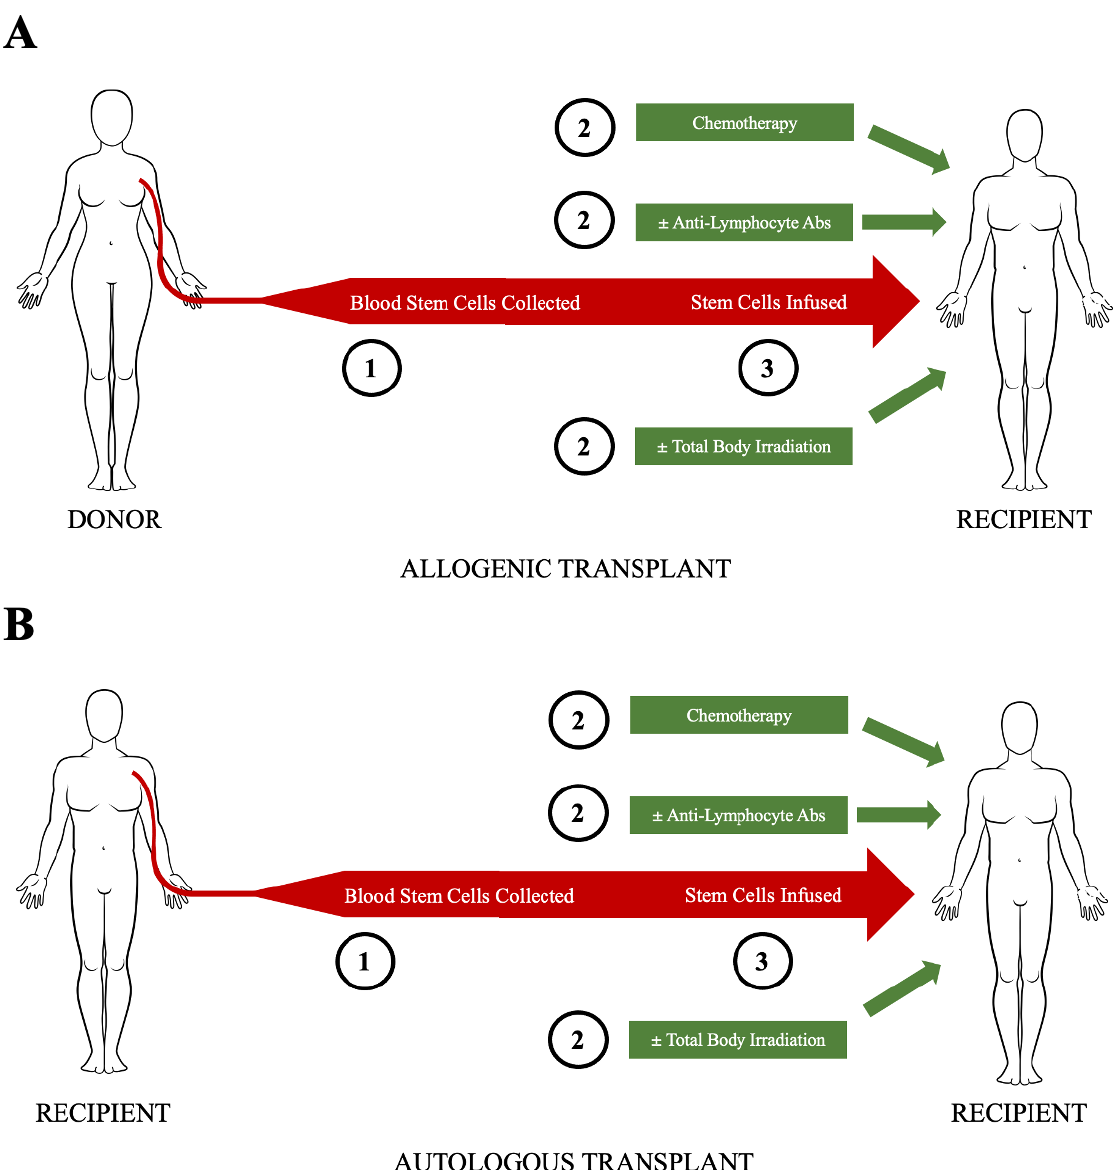
Figure 1. Schematic of hematopoietic stem cell transplantation (( A ), allogeneic, ( B ), autologous). Step No. 1 is stem cell mobilization (from marrow to blood) and collection by apheresis. Step No. 2 is chemotherapy, usually with anti-lymphocyte antibodies (e.g., antithymocyte globulin) and sometimes with total body irradiation. Step No. 3 is the infusion of the stem cells, usually fresh stem cells in the allogeneic setting and usually thawed, previously cryopreserved stem cells in the autologous setting. Step No. 4 (not shown here) is post-transplant supportive care (e.g., transfusions for low cell counts, antibiotics for